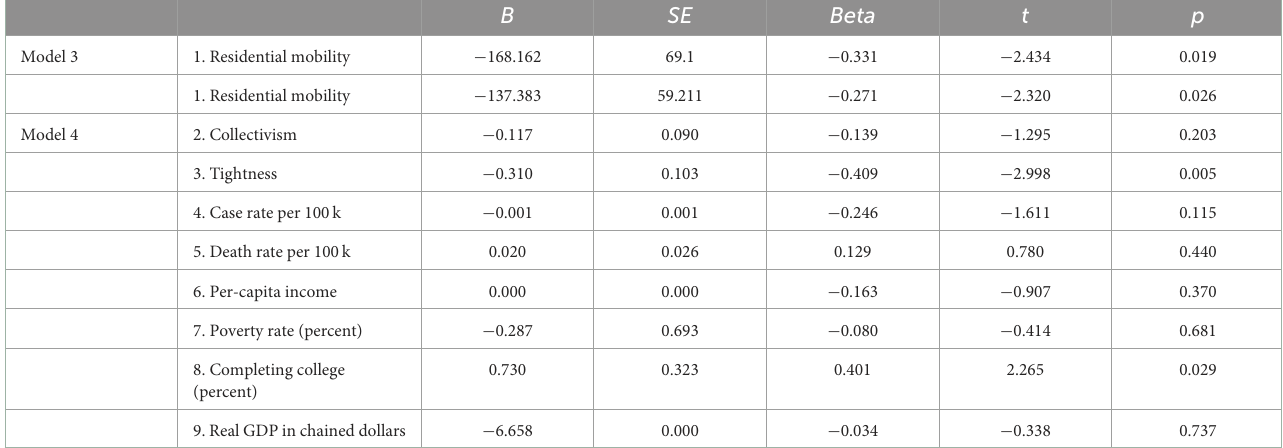
TABLE 3 Predictors of total population with at least one dose COVID-19 vaccination across U.S.